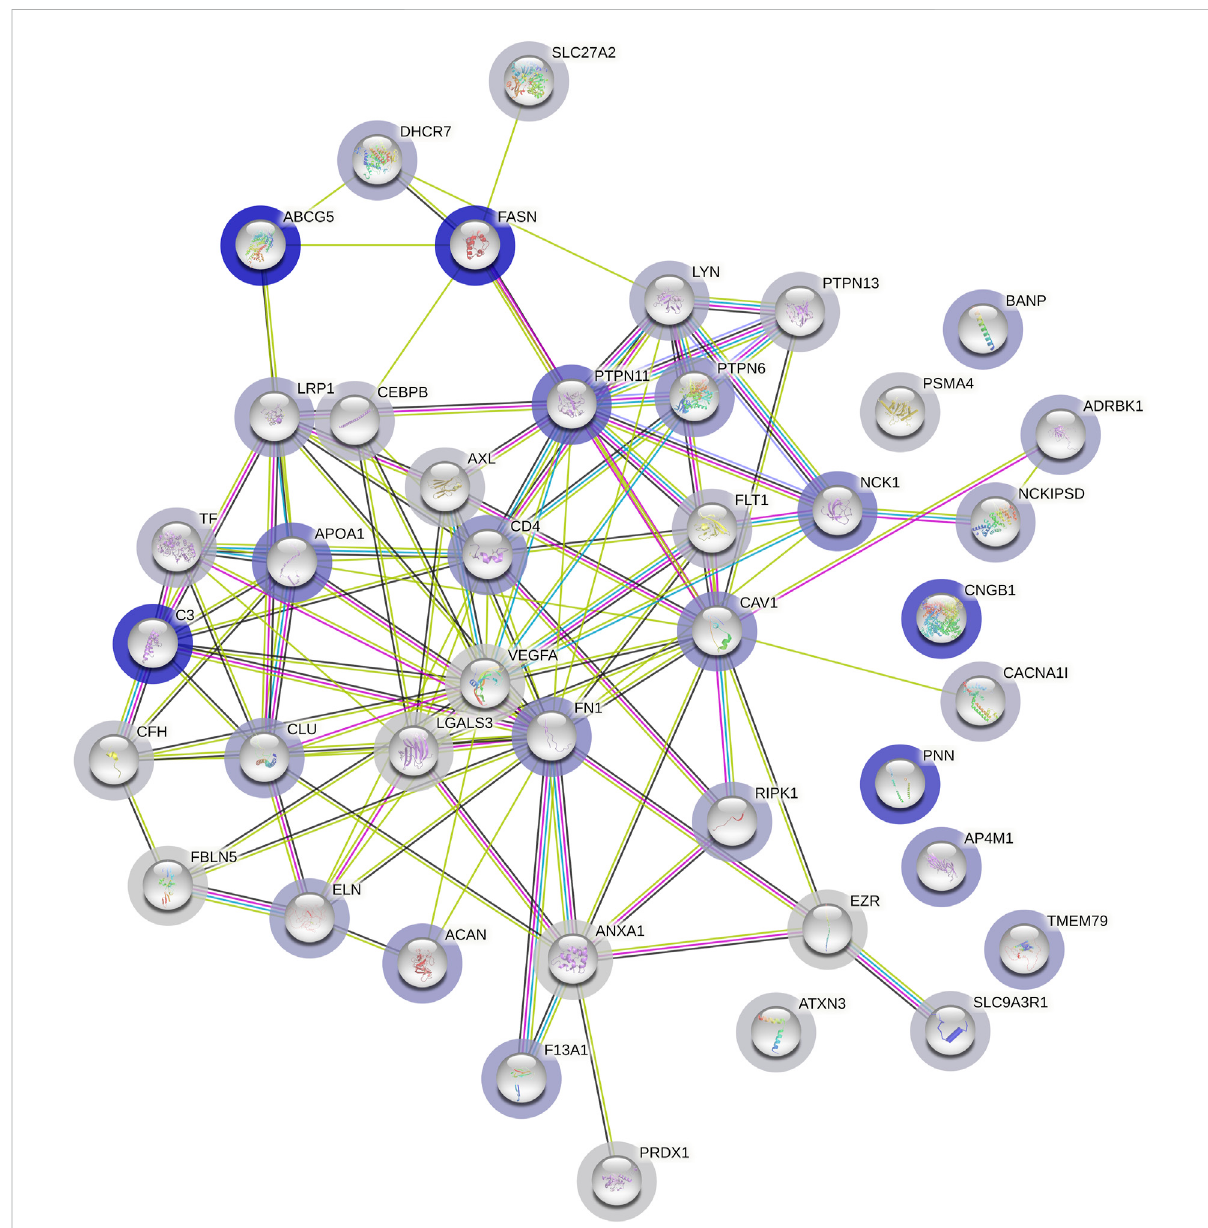
FIGURE 5 Protein-protein interaction network of the 42 genes in AMD gene collection. The blue halo around the gene indicates high betweenness while the gray halo indicates low betweenness.